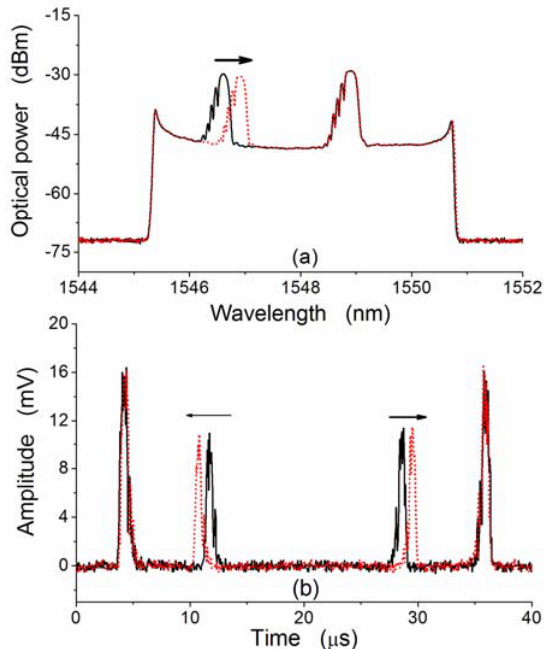
Figure 5. ( a ) Optical spectrum and ( b ) time-domain spectrum of the reflected light of